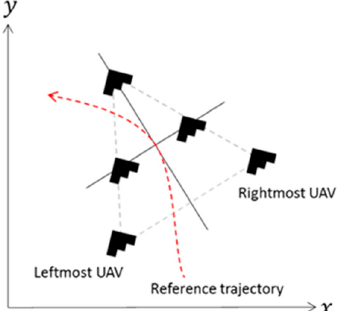
Figure 6. UAV formation taking a left turn.